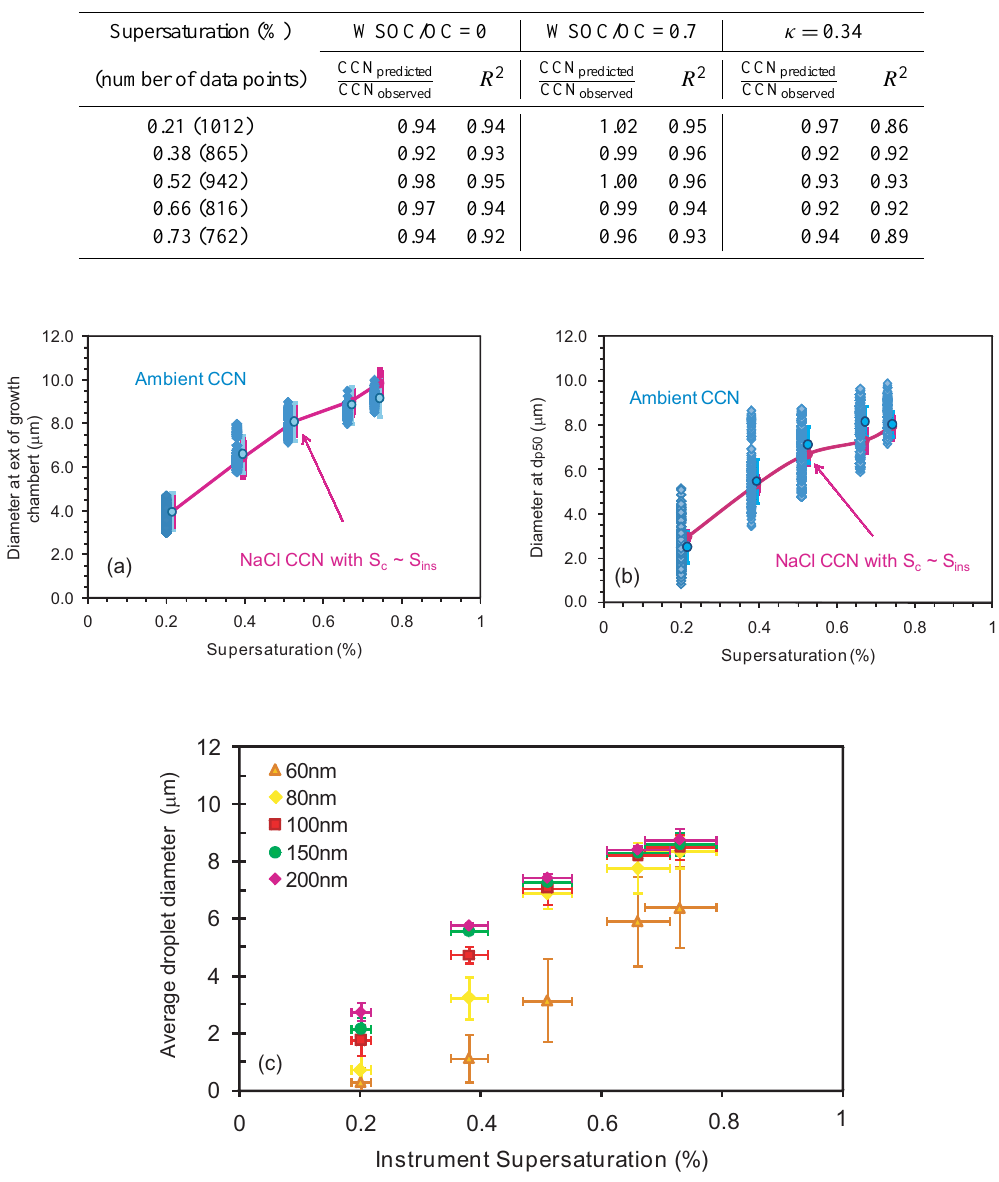
Fig. 11. (a) Droplet sizes of CCN at the different supersaturations for ambient and calibration aerosol for large particles (100nm) (b) Droplet sizes of ambient CCN at d p50 and (c) Average droplet diameter at different dry particle sizes, all as measured at the exit of the growth